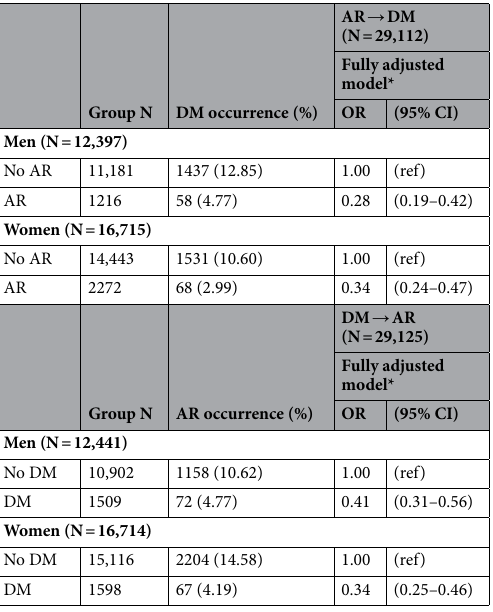
Table 2. Bi-directional association between allergic rhinitis (AR) and diabetes mellitus (DM) (N = 29,112; 29,125). *Adjusted for age, family income, education status, marital status, smoking, drinking frequency, sleep deprivation, dyslipidemia, BMI category (cut-off: 23.0 kg/m 2 ), and the number of comorbidities. AR allergic rhinitis, DM diabetes mellitus, OR odds ratio, CI confidence